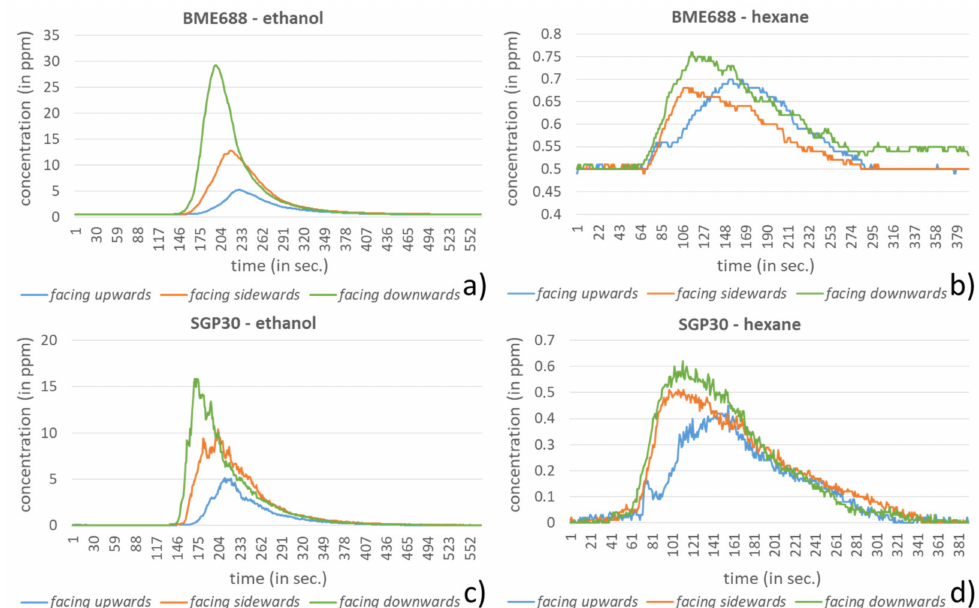
Figure 7. Measurement results for different orientations (facing upwards, sideways and downwards) for the BME688 sensor with ( a ) 10 µ L ethanol and with ( b ) 1 mL hexane and the SGP30 sensor with ( c ) 10 µ L ethanol and with ( d ) 1 mL